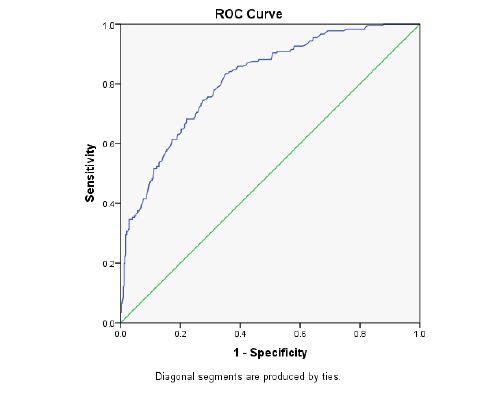
FIGURE 1: ROC ANALYSIS FOR MUAC AND TSFT IN DETECTING UNDERWEIGHT AND OBESE